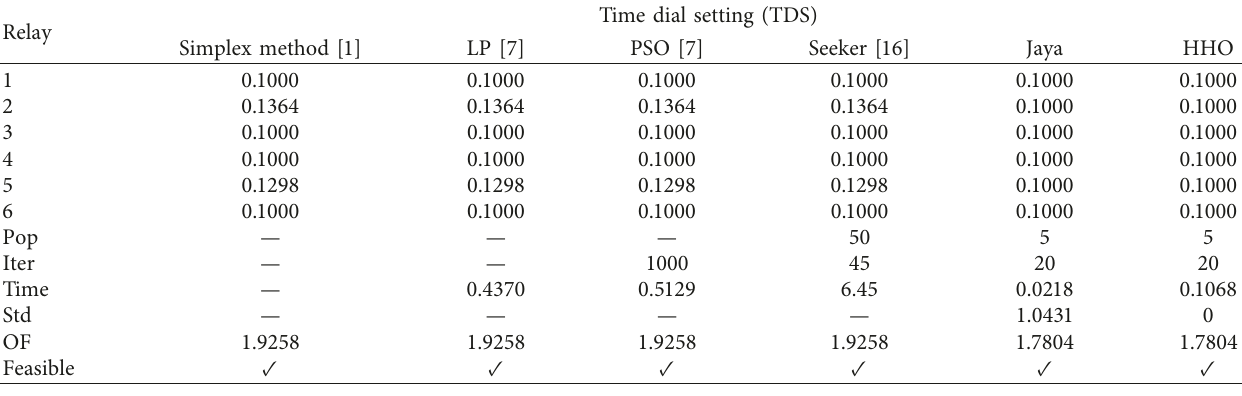
Table 2: Time dial setting for the 3-bus system by LP formulation.